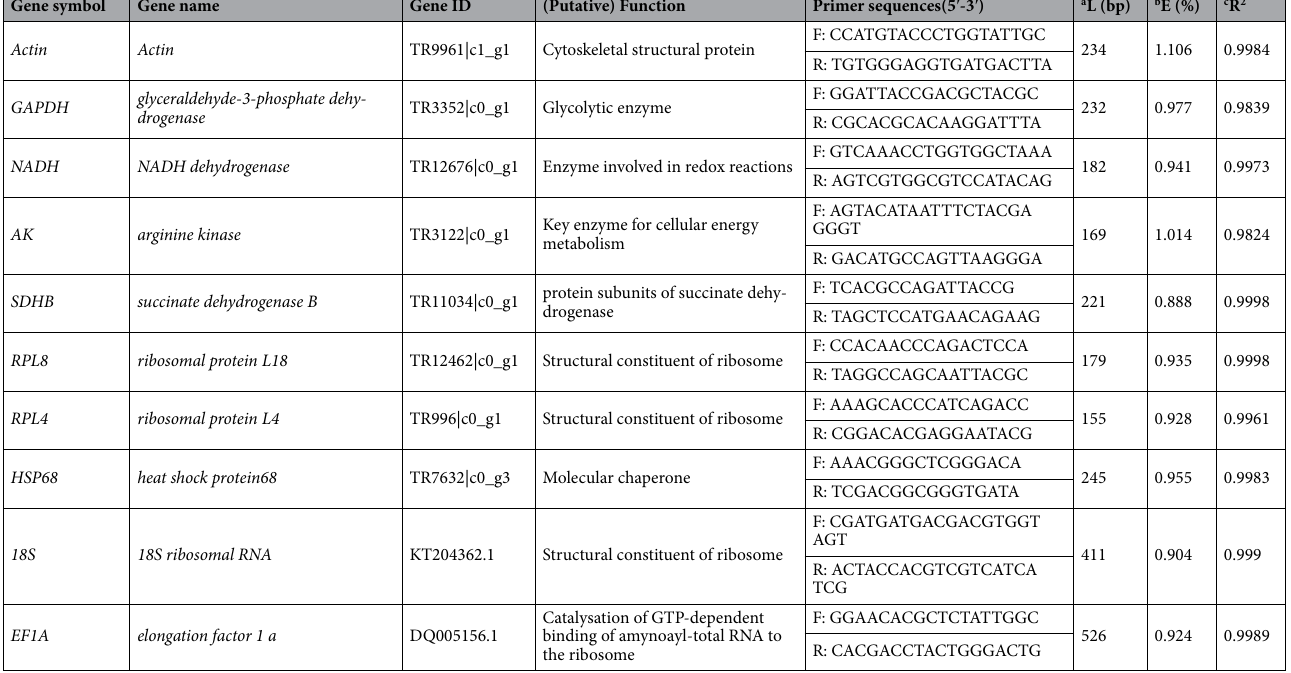
Table 3. Functions, primer sequences, and amplicon characteristics of the candidate reference genes analyzed in this study. a Amplicon length. b qRT-PCR efficiency (based on a standard curve). c Reproducibility of the qRT-